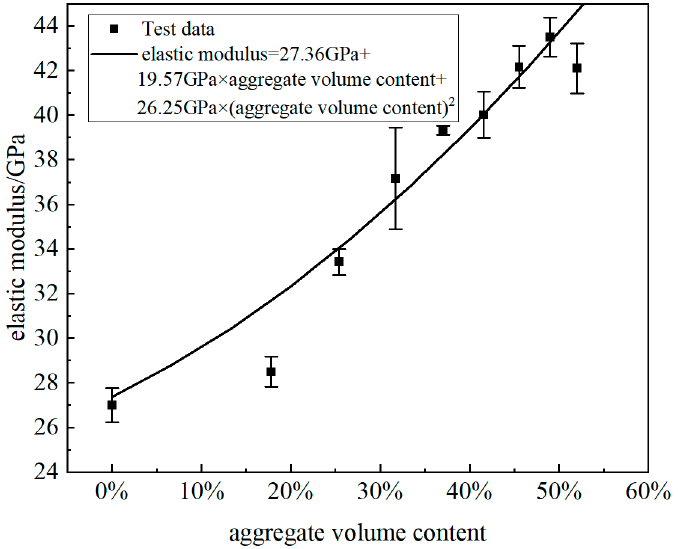
Figure 9. Relationship between aggregate content and elastic modulus of structural grout material.